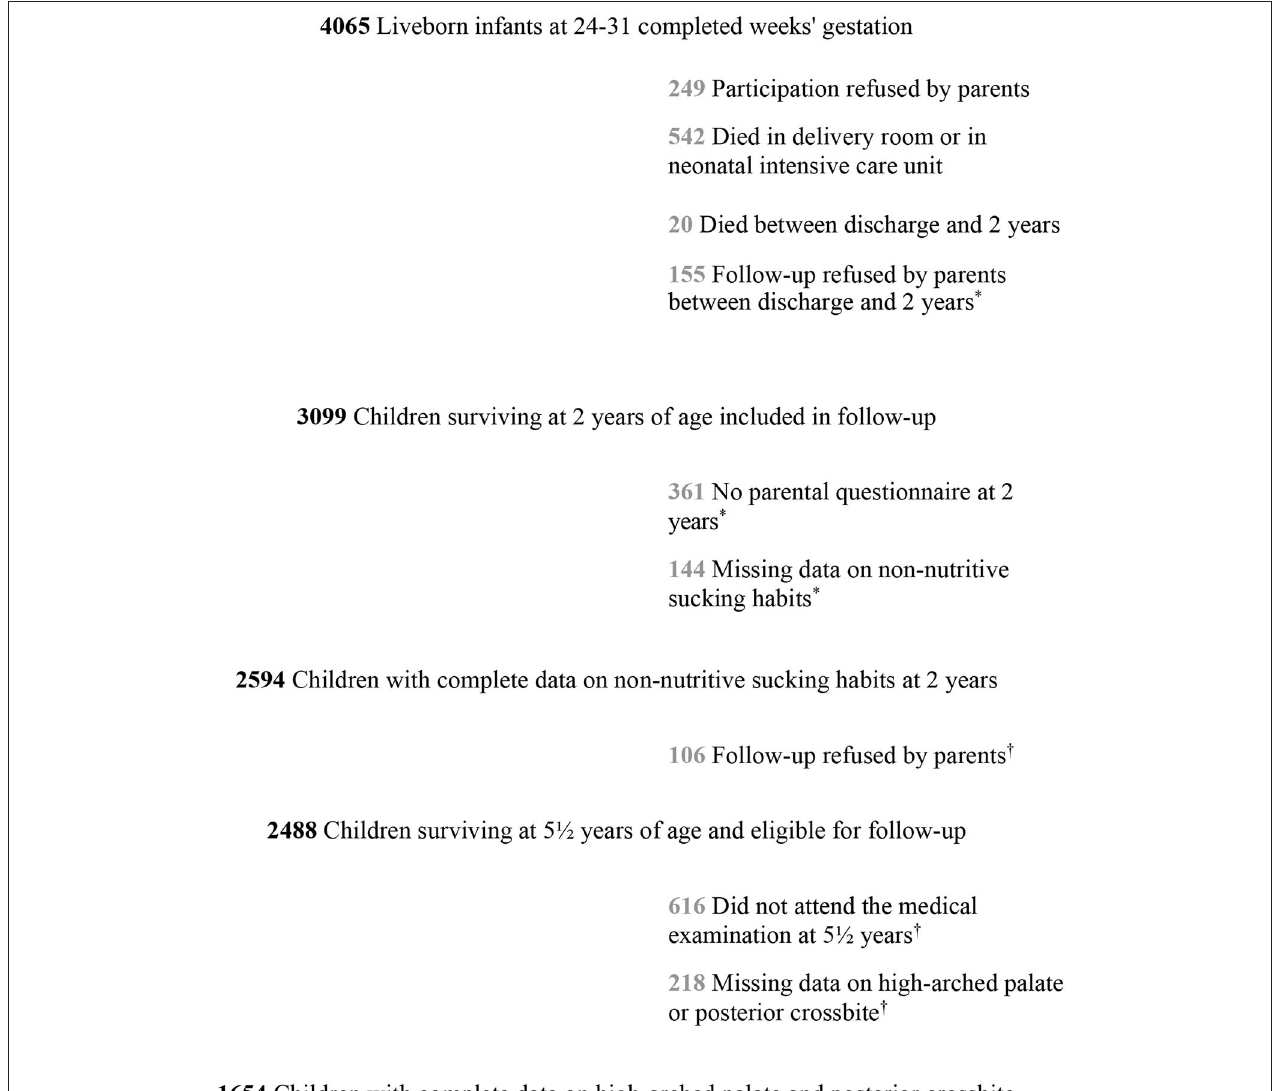
FIGURE 1 | Flow chart of the study population: EPIPAGE-2 cohort at 5 ½ years. * Considered “missing data on non-nutritive sucking habits at 2 years’ corrected age” = 660 children. † Considered “missing data at 5 ½ years” = 940 children .